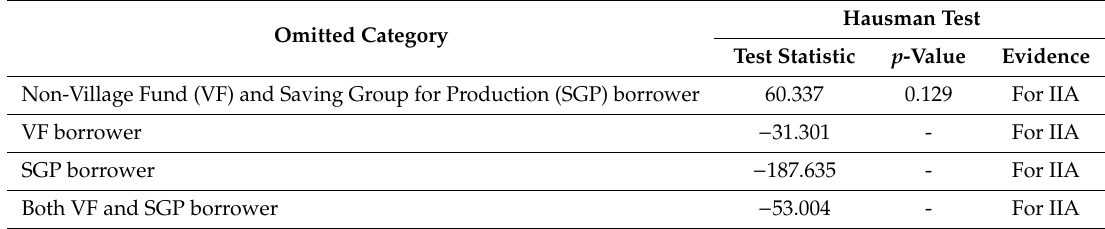
Table 1. The results of the Hausman test of Independence of Irrelevant Alternatives. Omitted Category